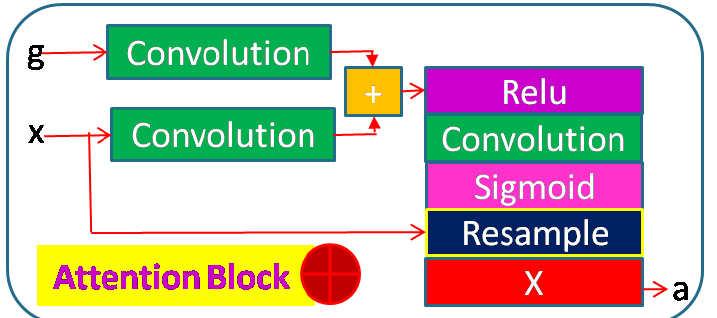
Figure 8. Skip layer with attention. This layer takes two inputs from encoder blocks of different scales, ‘g’ from the higher scale or input to the encoder and ‘x’ from the lower scale or output of the encoder, and feeds the decoder block with attention vectors